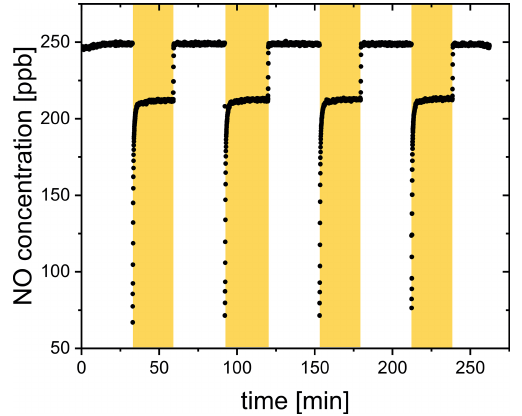
Figure 4. NO concentration raw data from a CWFT film containing Fe III ( Cit )/ CA (molar ratio of 0.07) with lamps on (yellow shaded region) and off at 29.3% RH and